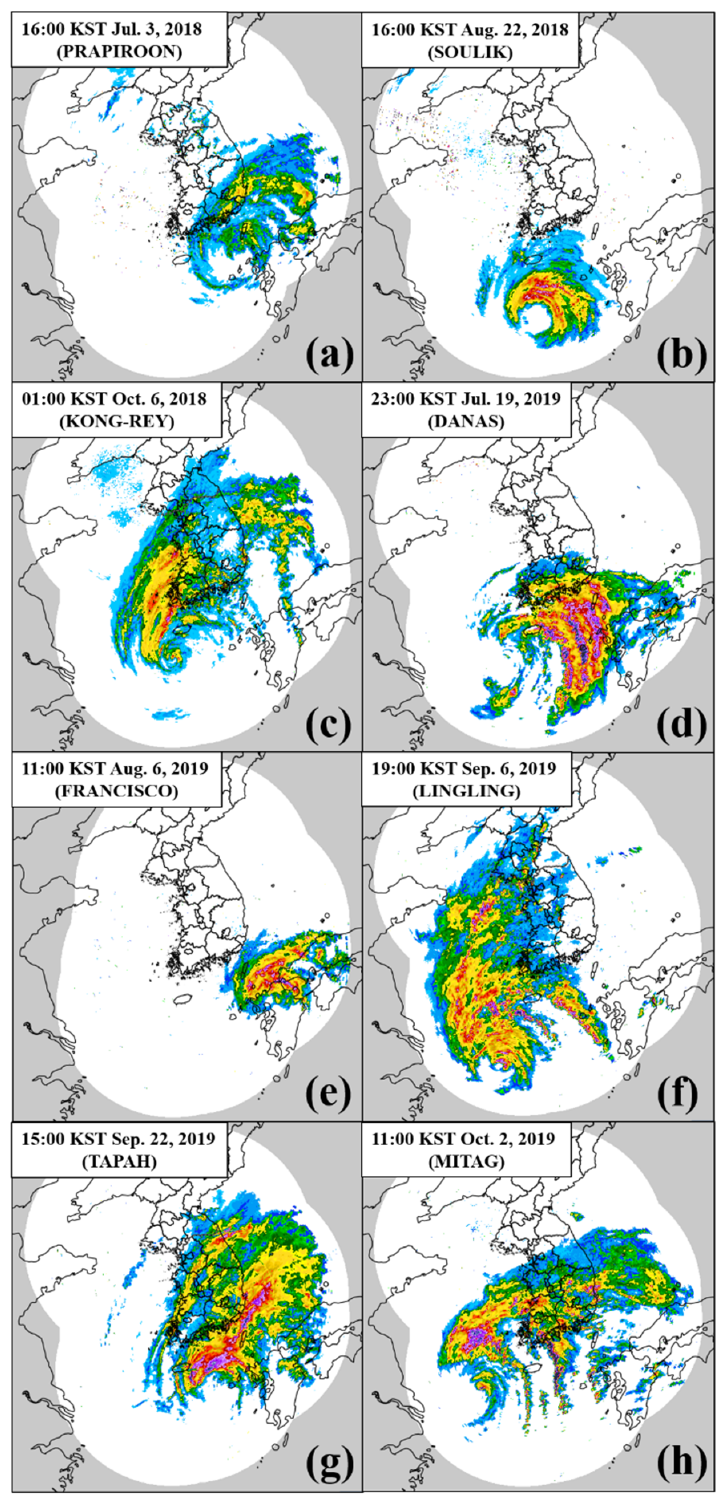
Figure 7. Composite images of radar reflectivity of typhoons that affected the Korean Peninsula between 2018–2019: ( a ) “PRAPIROON”, ( b ) “SOULIK”, ( c ) “KONG-REY”, ( d ) “DANAS”, ( e ) “FRANCISCO”, ( f ) “LINGLING”, ( g ) “TAPAH”, and ( h ) “MITAG”.